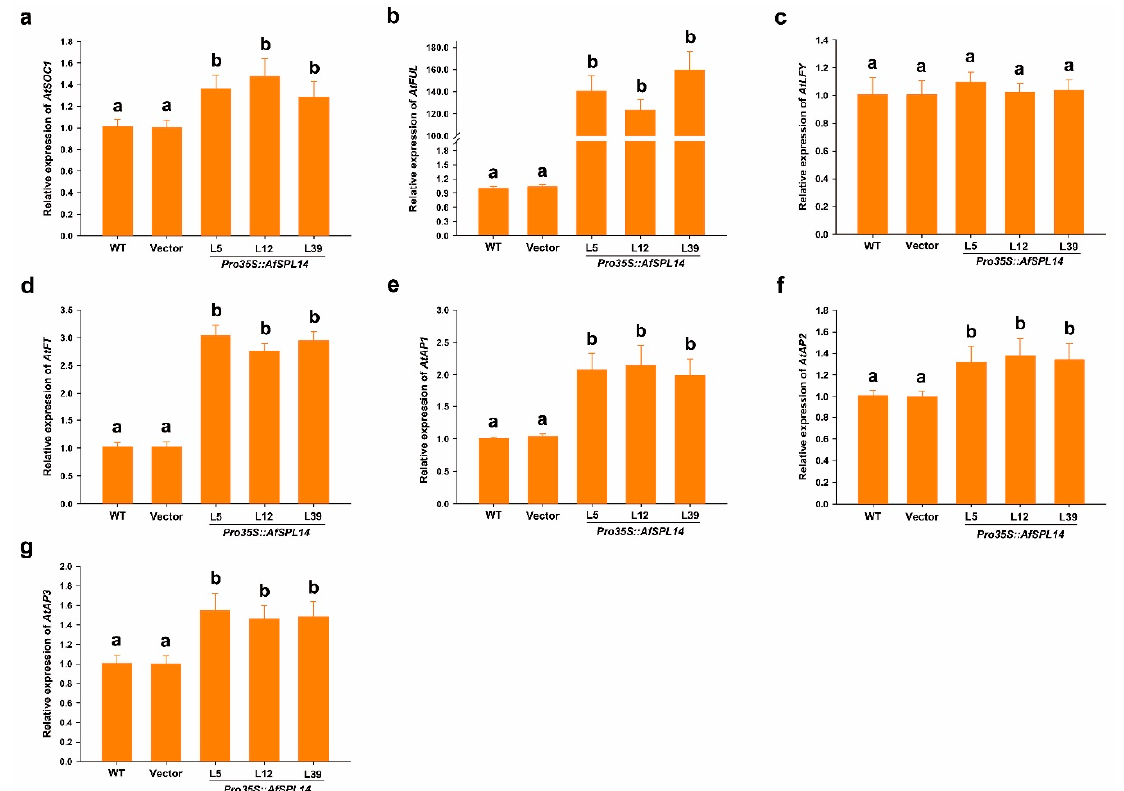
Figure 7. RT-qPCR analysis of flowering related genes at the shoot apex of WT, Vector and Pro35S::AfSPL14 transgenic plants. Relative expression of three flowering promoting genes, SUPPRESSOR OF OVEREXPRESSION OF CONSTANS 1 ( SOC1 ) ( a ), FRUITFULL ( FUL ) ( b ), LEAFY ( c ), and one florigen Flowering Locus T ( FT ) ( d ), and three flowering organ identify genes, APETALA1 ( AP1 ) ( e ), AP2 ( f ) and AP3 ( g ) was performed. Fourteen-day-old long-day-grown seedlings were used. Three biological replicates and three technical replicates were performed. Transcript levels were normalized using AtACTB gene as a reference. All primers used here are listed in Table S3 online. ANOVA was conducted, and means were separated by DNMRT.